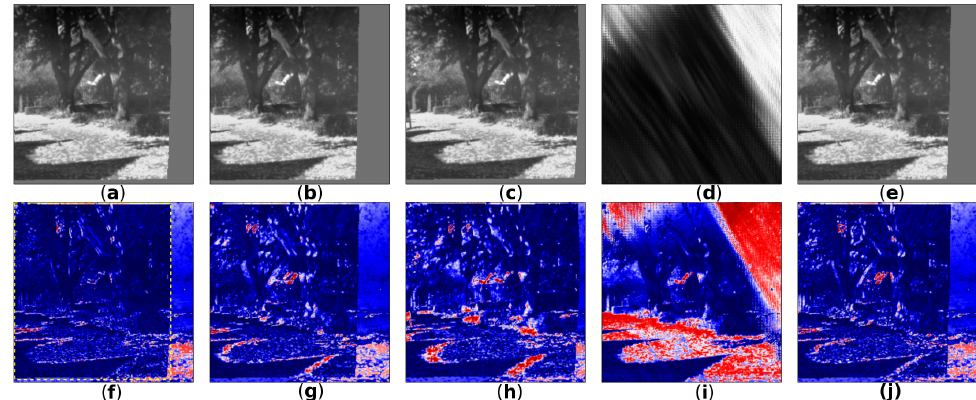
Figure 6. Sample MHDE outputs from different hypothesis pathways. ( a – e ): MHDE outputs from five pathways; ( d ) shows the output from an inactive pathway (i.e., a pathway that the network did not optimize); ( f – j ): reconstruction error for the hypotheses shown in ( a – e ). From ( f ), we can see that the reconstruction shown in ( a ) had the lowest error (yellow-dashed